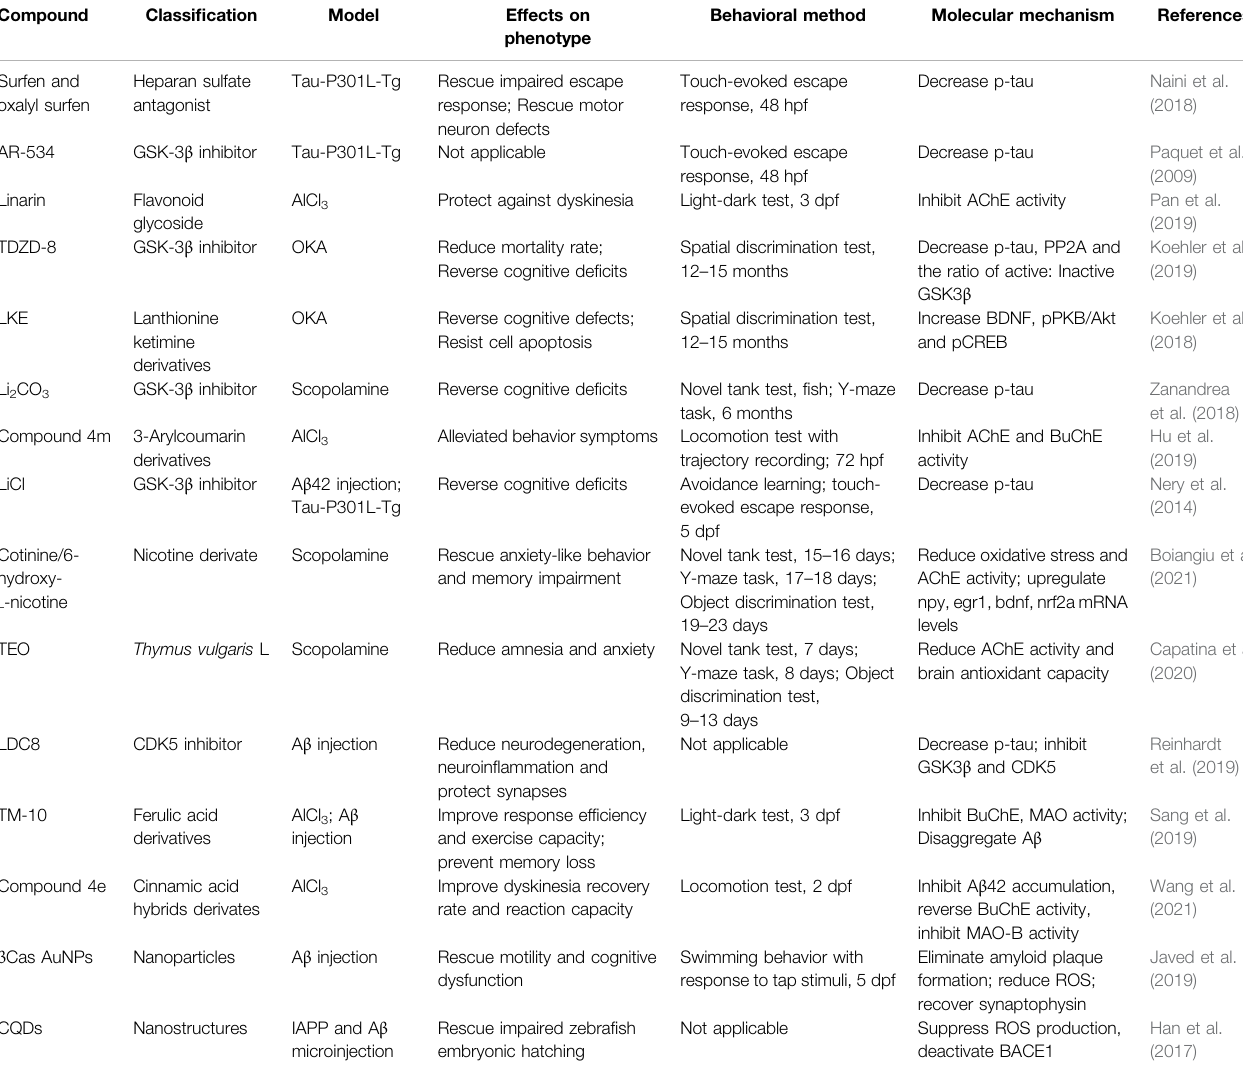
TABLE 1 | Drugs identi fi ed for AD treatment in zebra fi sh